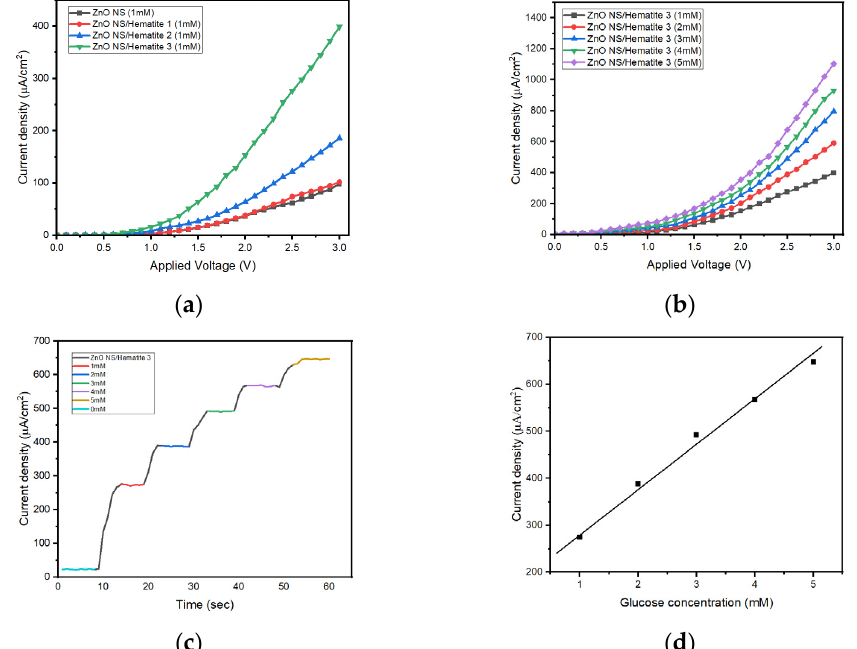
Figure 5. Testing coatings based on ZnO NS and ZnO NS/Hematite as non-enzymatic glucose sensors: ( a ) I-V curves of sensing properties for 1 mM glucose; ( b ) I-V curves of sensing properties of ZnO NS/Hematite3 nanocomposites for different concentrations of glucose; ( c ) amperometry of ZnO NS/Hematite3 to successive additions of increased concentrations of glucose solutions up to 5 mM; ( d ) calibrated plot recorded at 2.5 V.